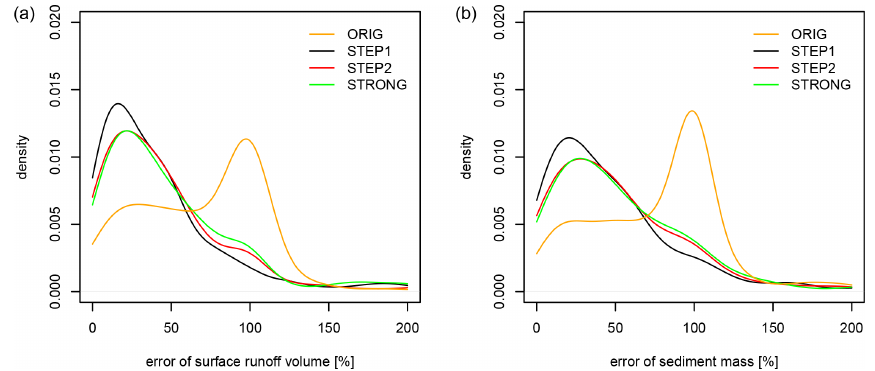
Figure 6. Error propagation of skinfactor prediction in the surface runoff (a) and sediment mass (b) , a density plot of the percent error. Outlying experiments (error > 200%) create 6%–9% of the validation experiments. Experiments with no simulated runoff are evaluated as 100% error, which explains the significant peak in the ORIG